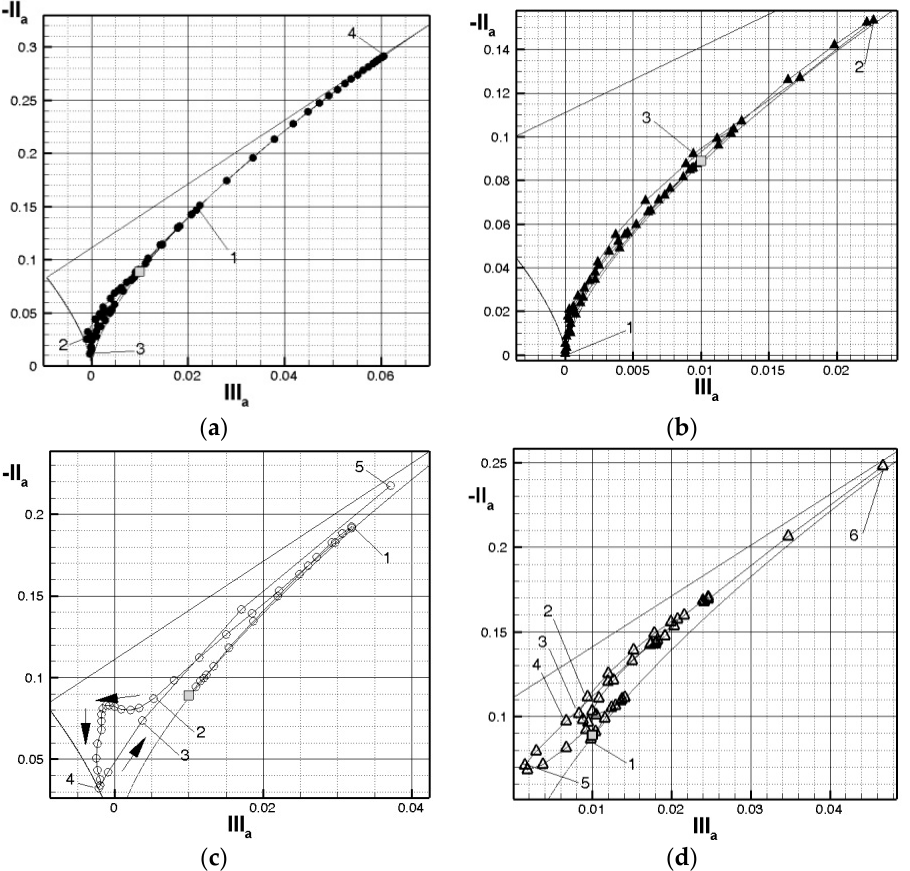
Figure 10. Trajectories of the anisotropy invariants for four radii defined by the angle φ : ( a ) 180°, ( b ) 0°, ( c ) 270°, and ( d ) 90°.